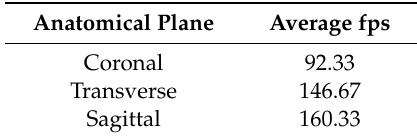
Table 3. Computational performance in fps.